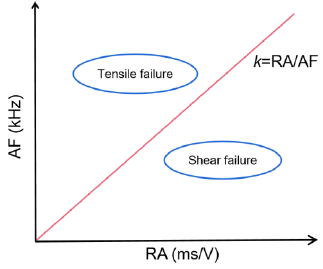
Figure 9. Fracture mechanism analysis based on AF and RA.